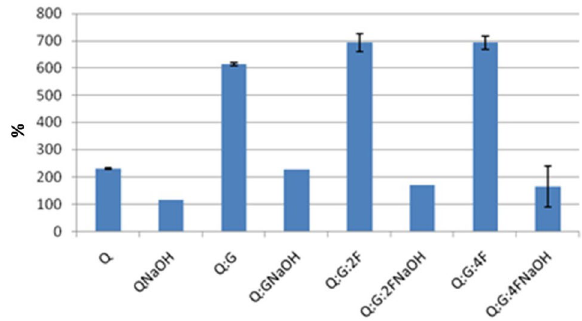
Fig. 6 Gelatin and heparin chitosan membrane swelling assay